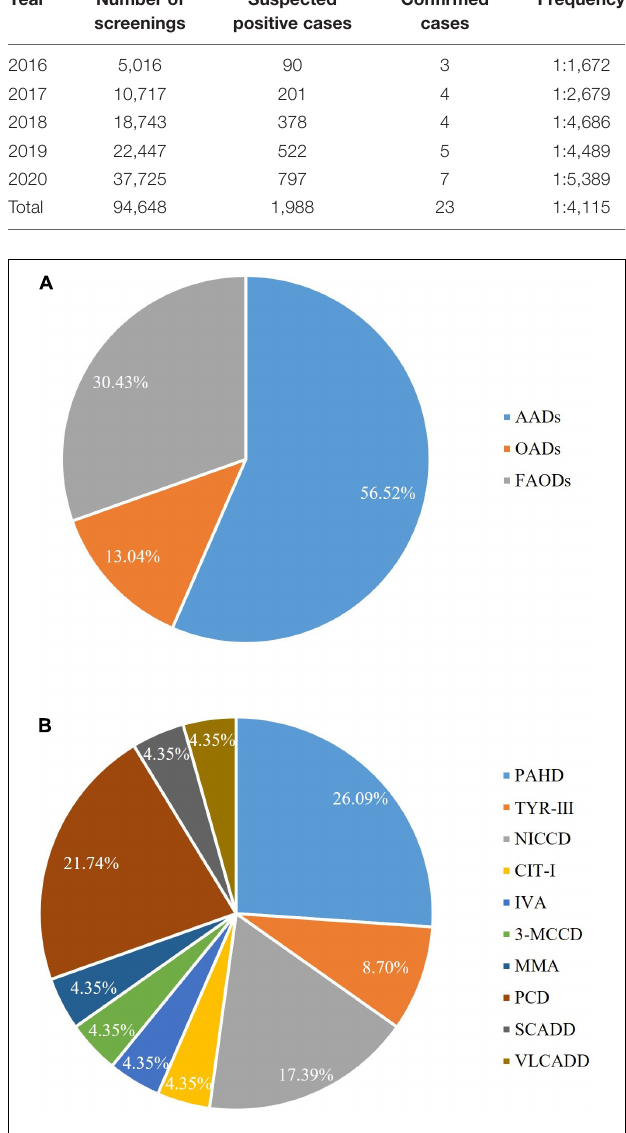
and citrullinemia type I (CIT-I). The overall incidence rate was 1:4,115 ( Table 2 ).